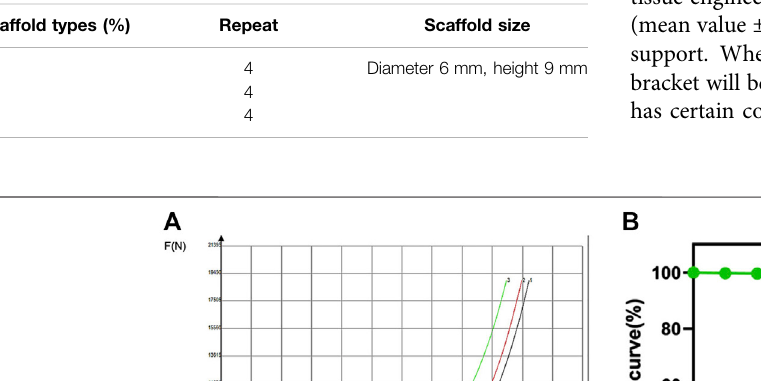
Frontiers in Bioengineering and Biotechnology |